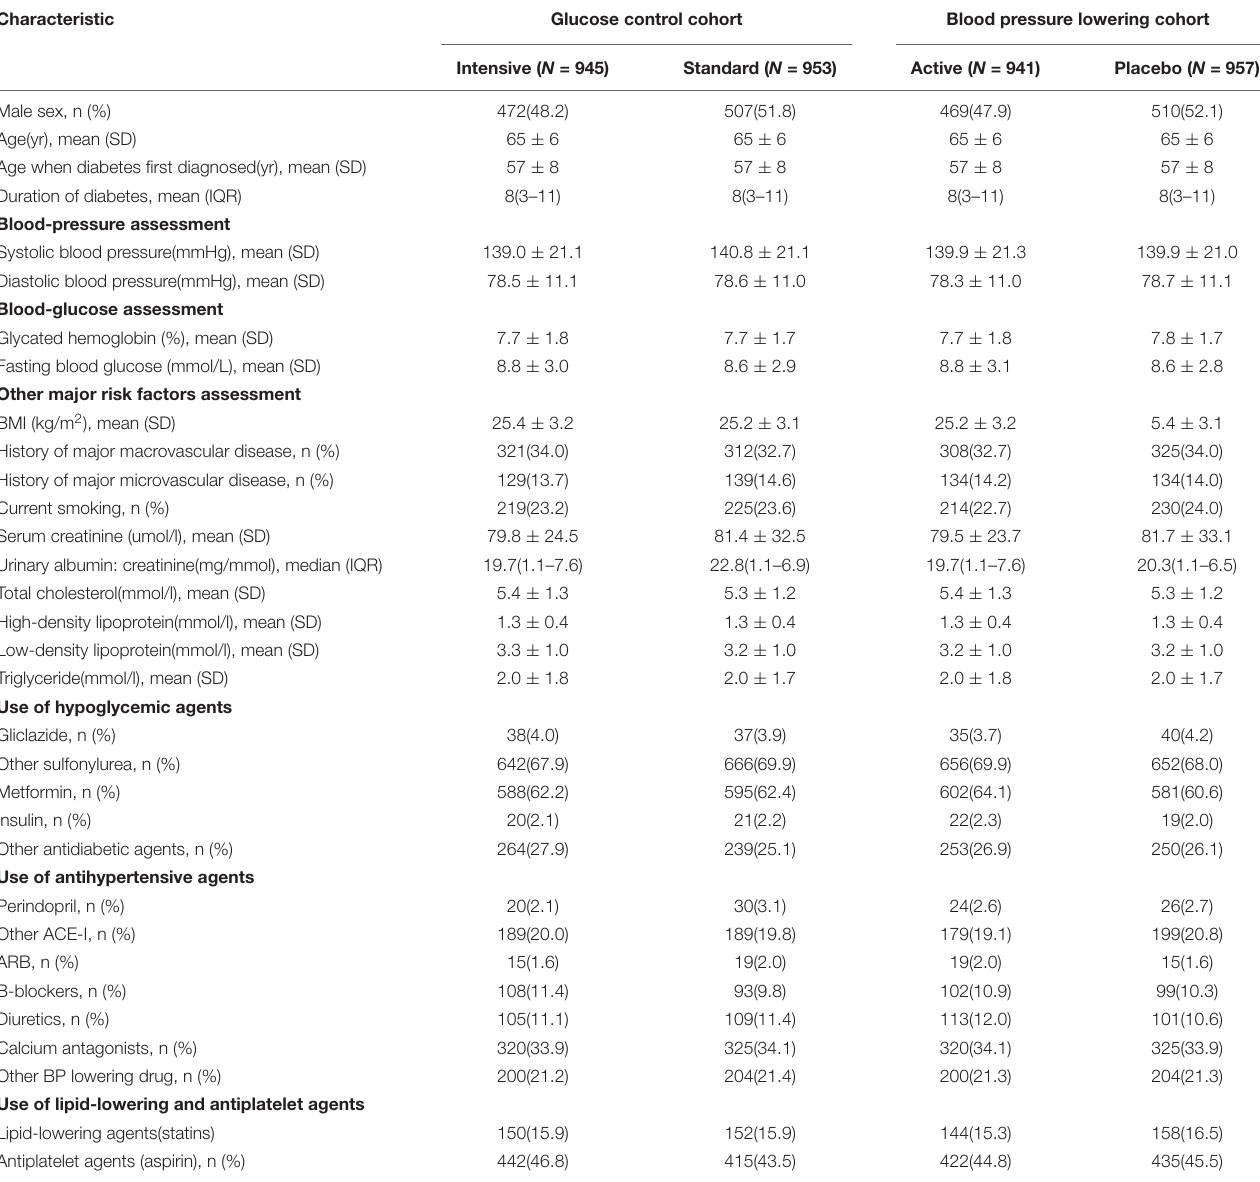
TABLE 1 | Clinical characteristics of patients at baseline according to glucose control cohort and blood pressure lowering cohort ∗ .